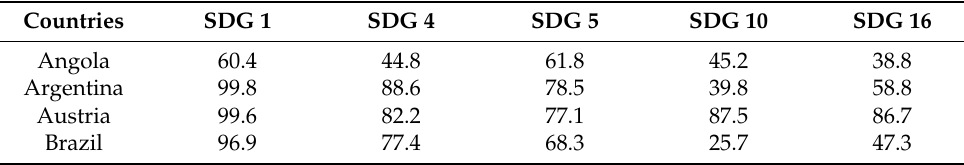
Table A1. Values of Social